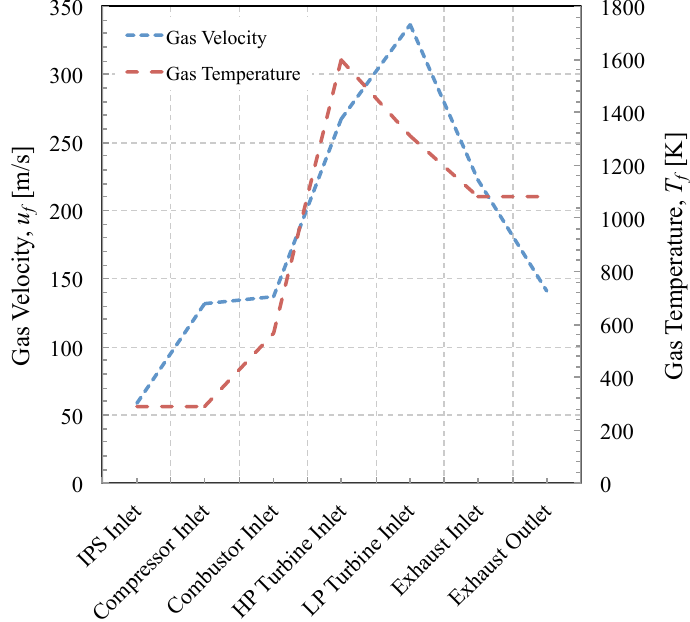
Figure 6. Mean gas velocity and temperature through the